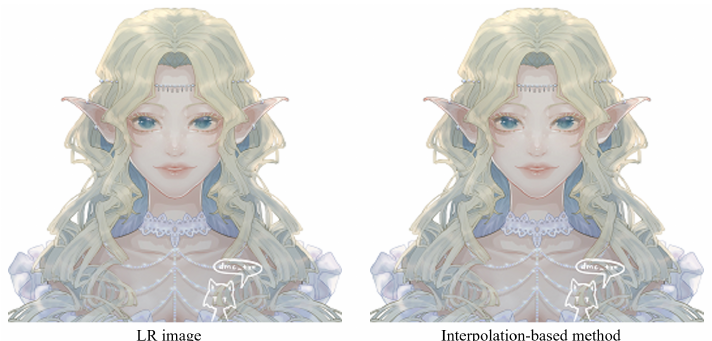
Figure 3. The blur result of interpolation-based algorithms. The image on the left is the original anime image. The image on the right is the super-resolution anime image obtained by the interpolation algorithm. The conventional interpolation algorithm does not consider the characteristics of the edge. After the image was processed, the blurring phenomenon can be noticed at the edge, which affects the quality of the image. The image is adopted from